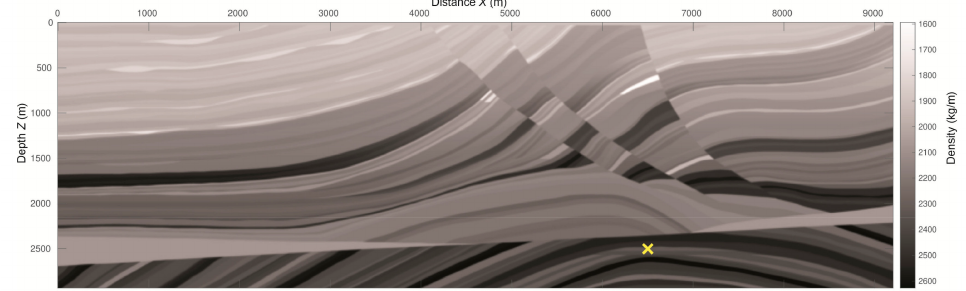
Figure 4. Two-dimensional Marmousi model. The yellow cross indicates the location of the source of the seismic wave used in the numerical simulation, the vertical scale indicates layer densities.